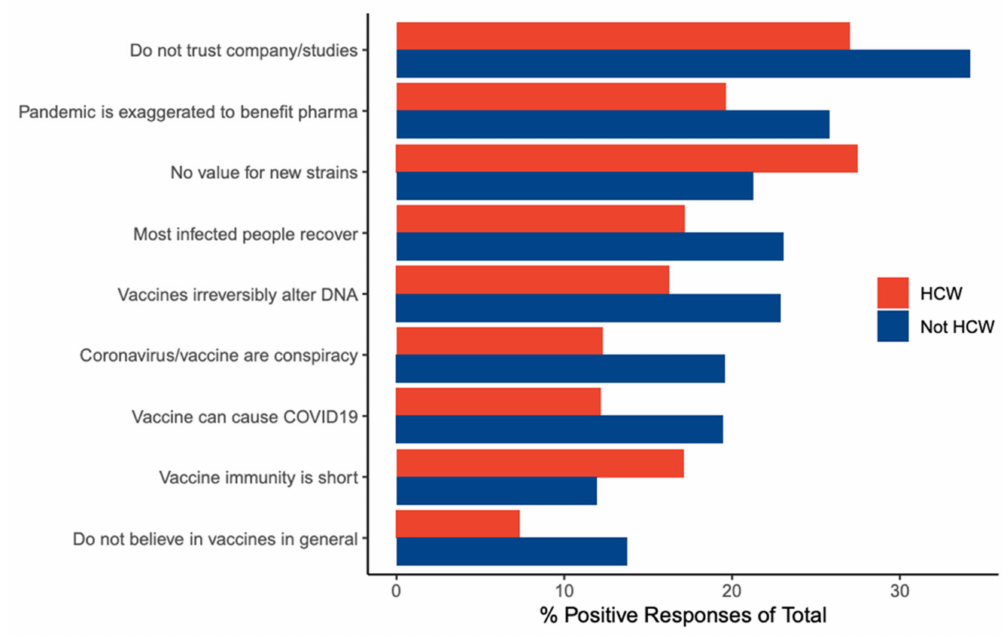
Figure 5. Bar plot showing the barriers with more than 5% difference between HCWs and